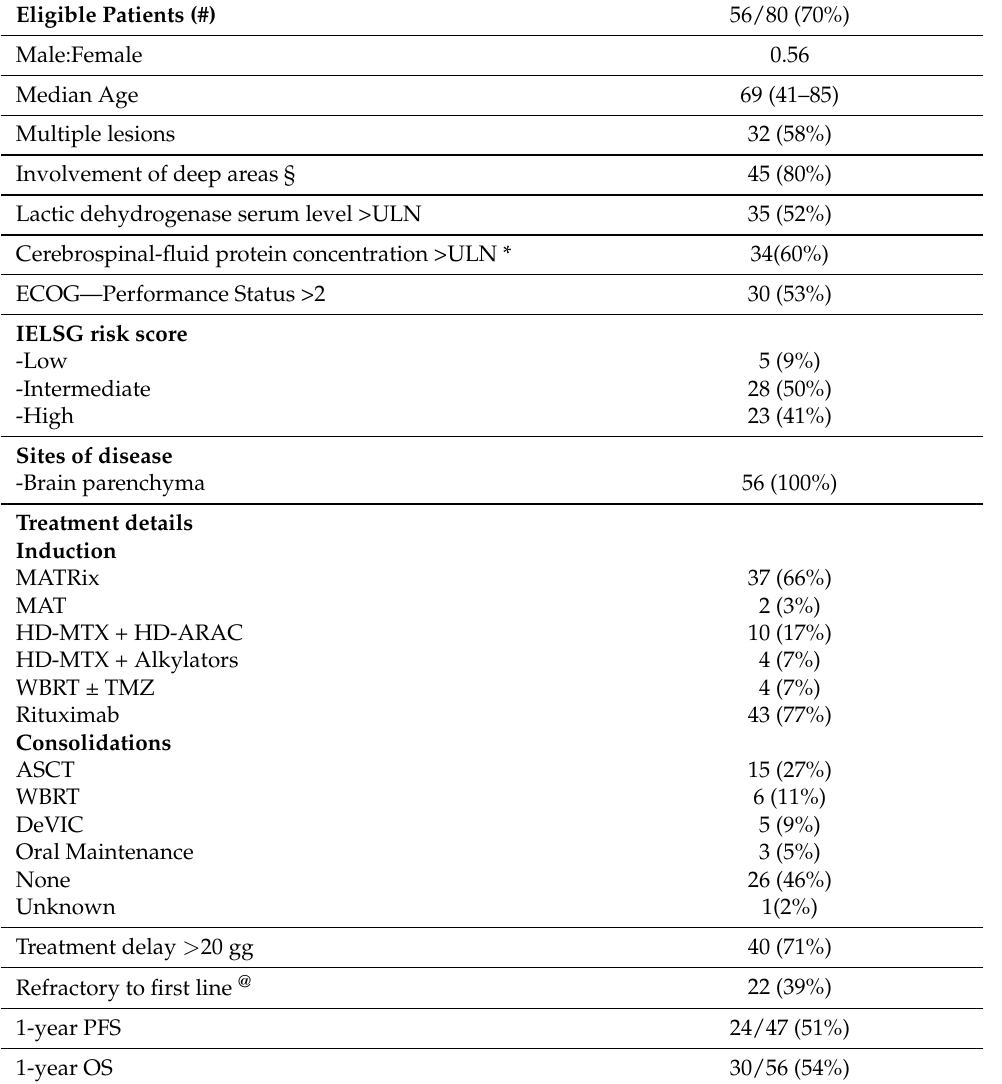
Table 1. Description of the patient dataset (Group